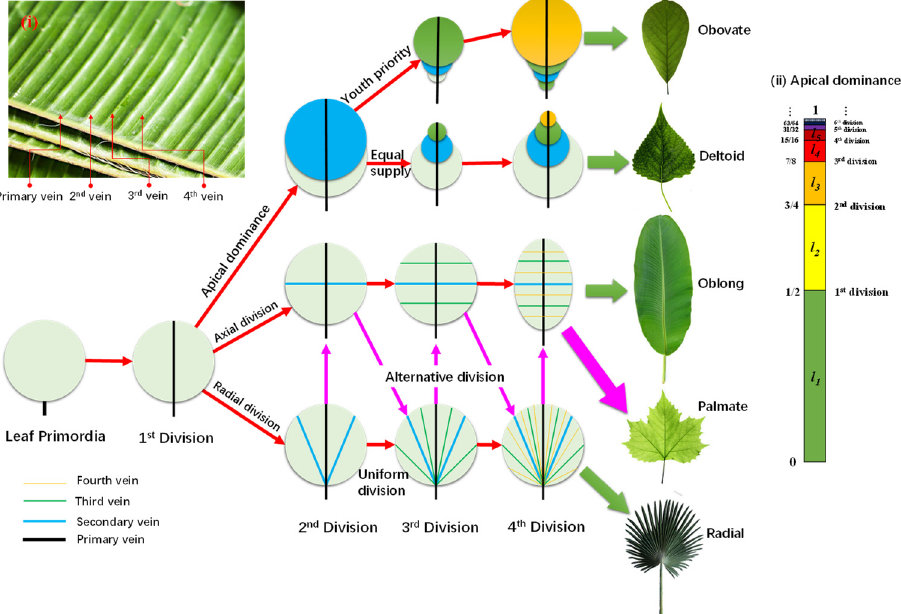
Figure 2. Universal formation routes of different leaf shapes, based on different division sequences of leaf primordia.